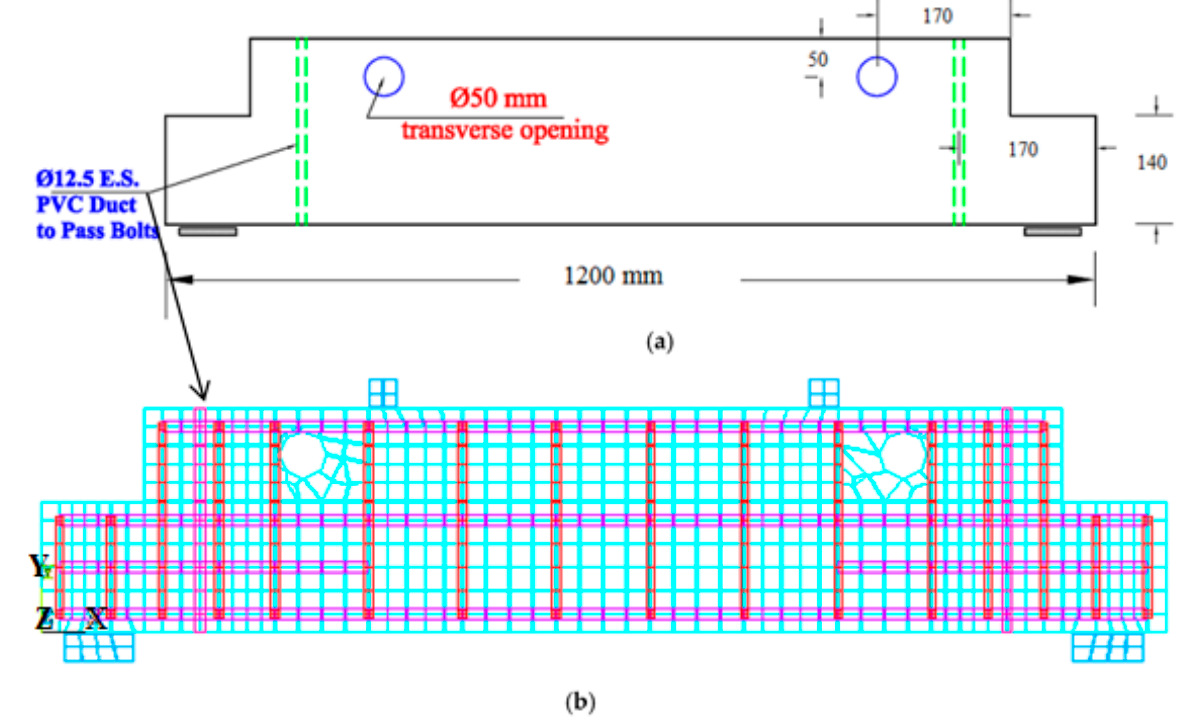
Figure 5. Experimental details and numerical simulations of model DET4. ( a ) Geometry layout in the previous experimental investigation [39]. ( b ) Numerical modelling.